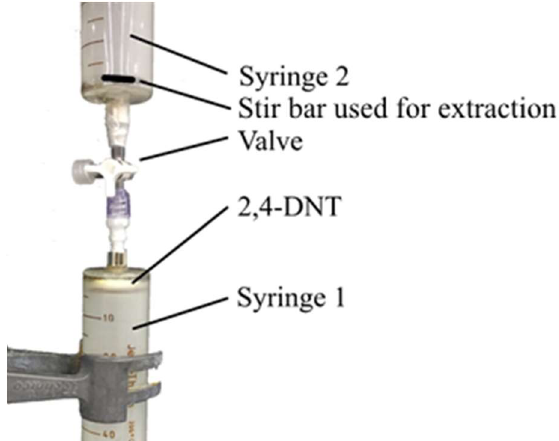
Figure A6. Experimental set-up to create a 2,4-DNT saturated headspace in a defined volume. Two glass syringes were connected using a closed valve. 2,4-DNT (150 mg) was solved in deionized water (2 mL), transferred in syringe 1 and incubated for 24 h. On the next day, the valve was opened and the whole headroom (50 mL) was transferred into Syringe 2 containing a TDS twister. The twister was then analyzed using GC-MS.